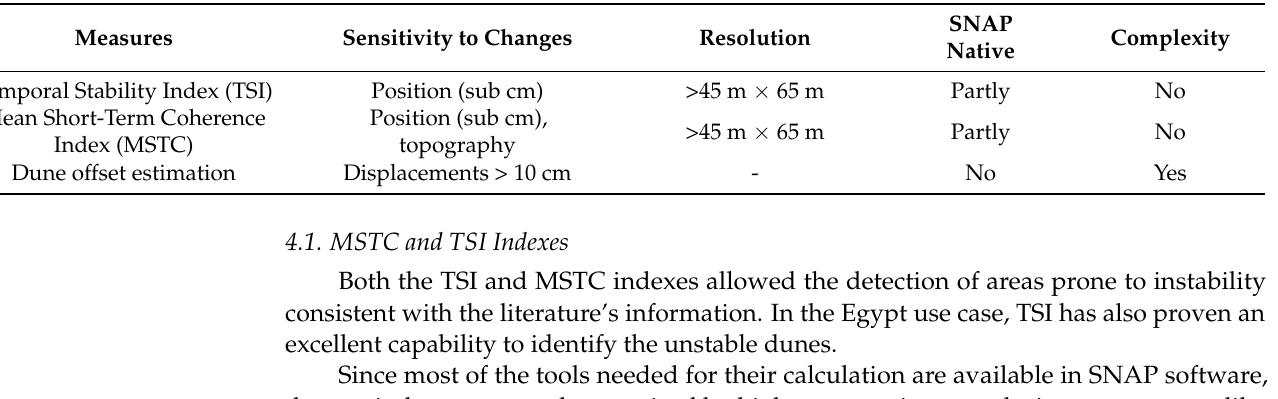
Table 2. Main characteristics of the SAR-derived measures.